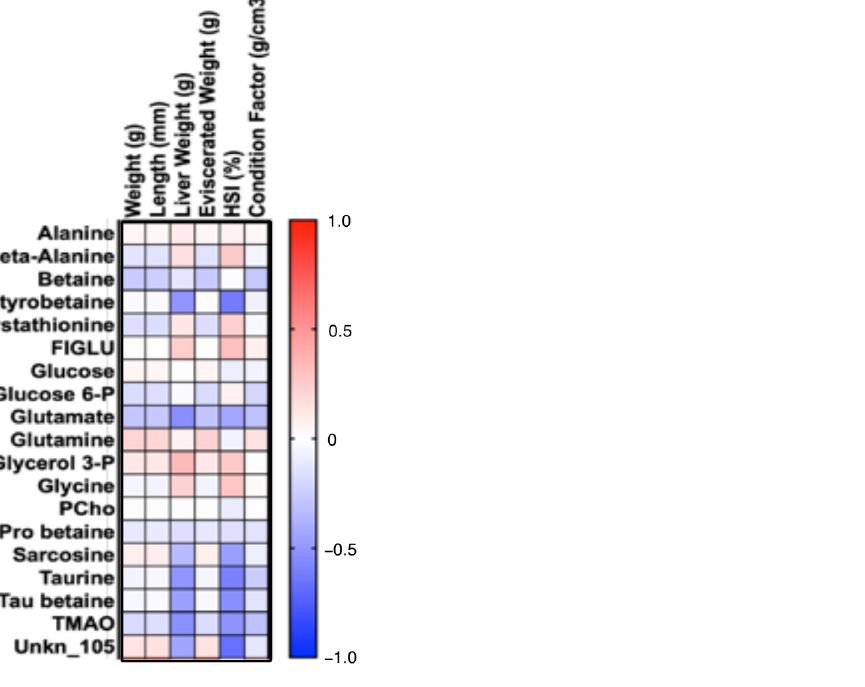
Figure 6. Spearman’s correlation matrix showing correlation of metabolite levels of the 19 most discriminating metabolites with 6 performance indices (body weight, total length, liver weight, eviscerated weight, hepatosomatic index (HSI), and condition factor). A gradient color scale from red (positive correlation) to blue (negative correlation) indicates values of Spearman’s rho correlation coefficients. Table 2. Spearman’s rho correlation coefficients of the 19 most discriminating metabolites with 6 performance indices (body weight, total length, liver weight, eviscerated weight, hepatosomatic index (HSI), and condition factor).